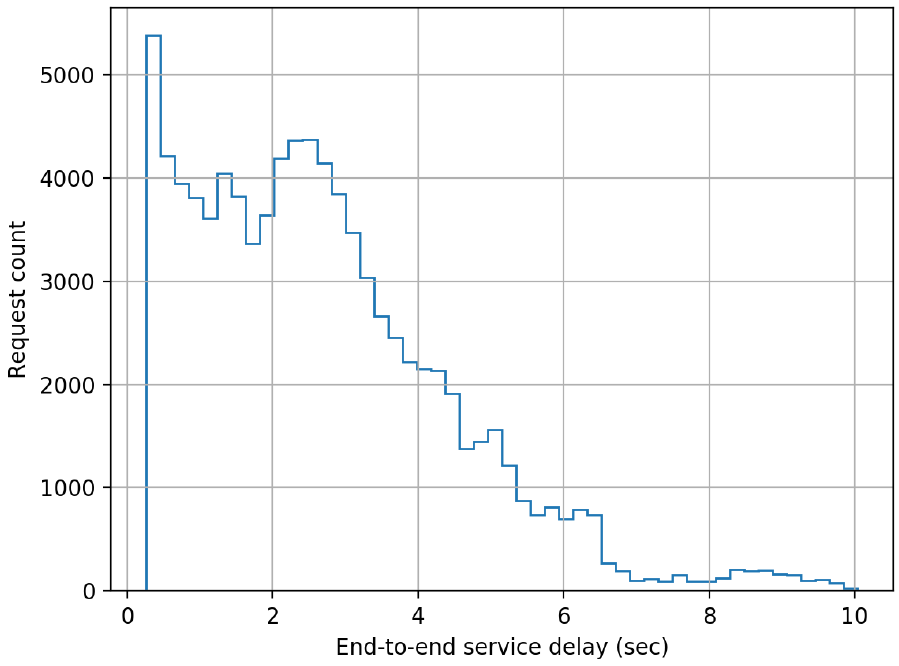
Figure 7. Distribution of end-to-end service delay at a mean request rate of 18 requests-per-second